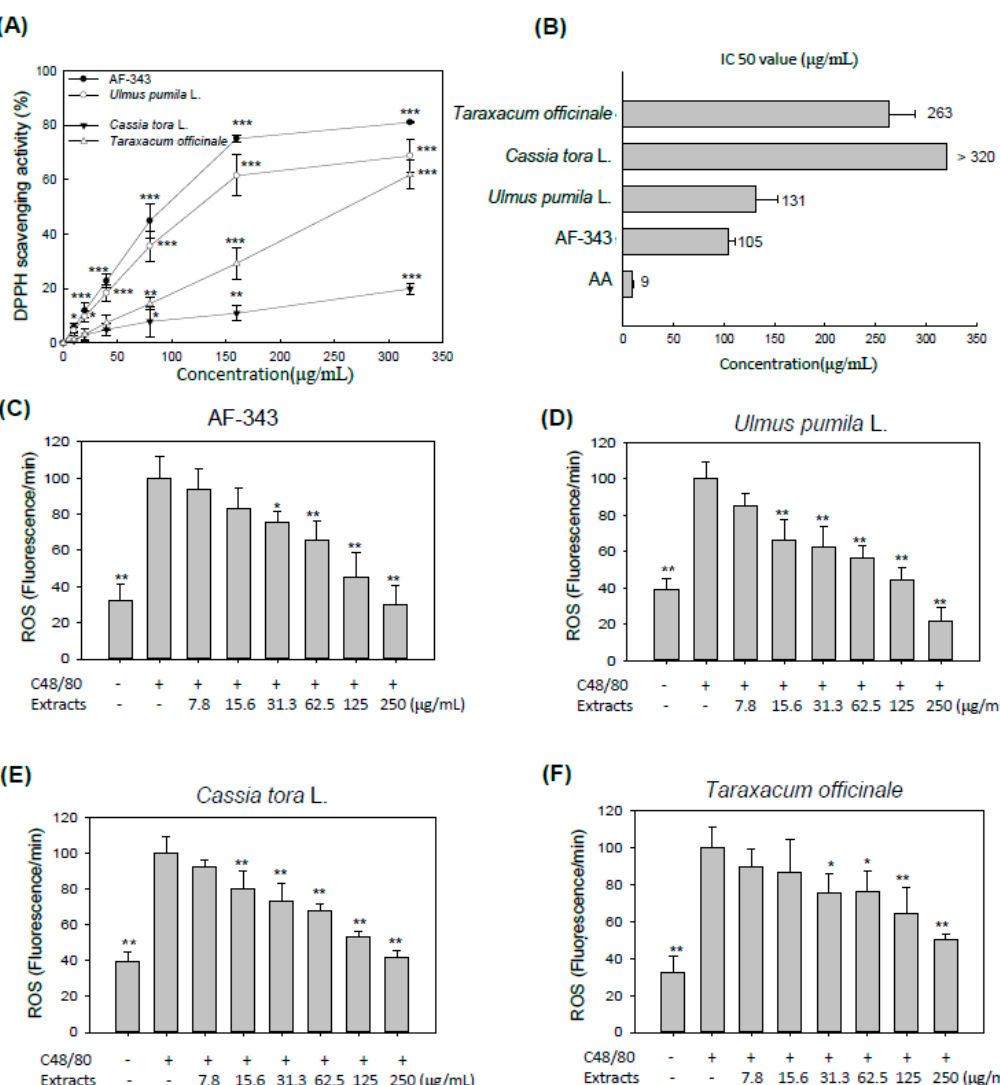
Figure 4. Antioxidative effects of AF-343 and extracts of Ulmus pumila L., Cassia tora L., and Taraxacum officinale on RBL-2H3 cells. ( A ) DPPH scavenging activity and ( B ) half-maximal inhibitory concentration (IC 50 ) values of AF-343, and extracts of Ulmus pumila L., Cassia tora L., and Taraxacum officinale at various concentrations (10, 20, 40, 80, 160, and 320 μ g/mL). The results are expressed as the means ± SD from three independent experiments. AA, ascorbic acid. ( C – F ) RBL-2H3 cells were preincubated with various concentrations (7.8, 15.6, 31.3, 62.5, 125, and 250 μ g/mL) of AF-343 or Ulmus pumila L., Cassia tora L., or Taraxacum officinale extract for 1 h. The cells were treated with 500 μ g/mL compound 48/80 for an additional 30 min. Changes in ROS levels were detected after the cells were treated with 2 ′ ,7 ′ -dichlorofluorescein diacetate (DCFH-DA) (25 μ M), an oxidant sensing probe. The results are expressed as the mean ± SD of three independent experiments. * p < 0.05 and ** p < 0.01 vs. the compound 48/80 only group; C48/80, compound 48/80.